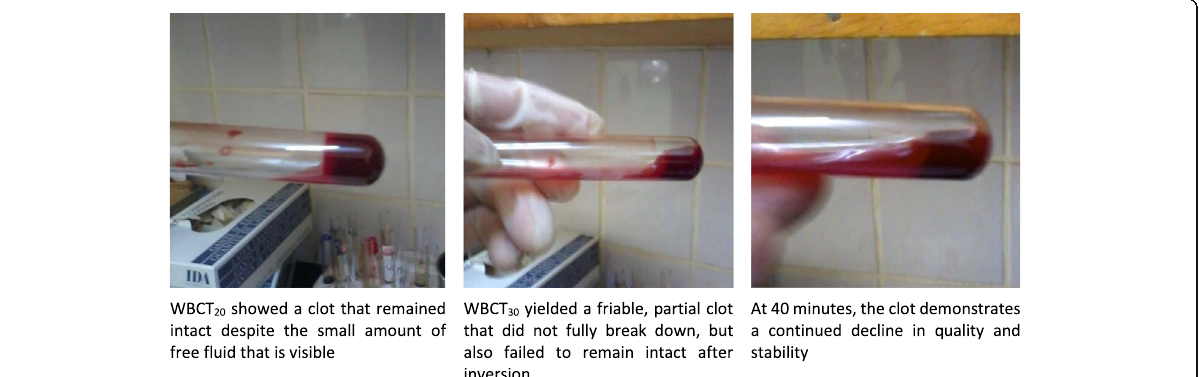
Fig. 3 Discrepancy in WBCT results at 20 and 30 minutes in a patient with an Echis ocellatus envenomation. Transient, asymptomatic resumption of coagulopathy at H24 by WBCT30 alone. This patient (case no. 12) presented to the hospital less than 1 h after an Echis ocellatus bite to the 5 th finger of his right hand and was already experiencing completely incoagulable blood (Grade 2) at both reading times despite the absence of any bleeding from the bite site or elsewhere. Two vials of antivenom were administered at H 0 and additional two vials were given at H 3 when assessment revealed a new onset of gingival hemorrhage in addition to persistence of abnormal WBCT results. Bleeding ceased within an hour and WBCT20/WBCT30 were both normalized during the next evaluation at H 6 . There was a brief resumption of coagulopathy by WBCT30 at H